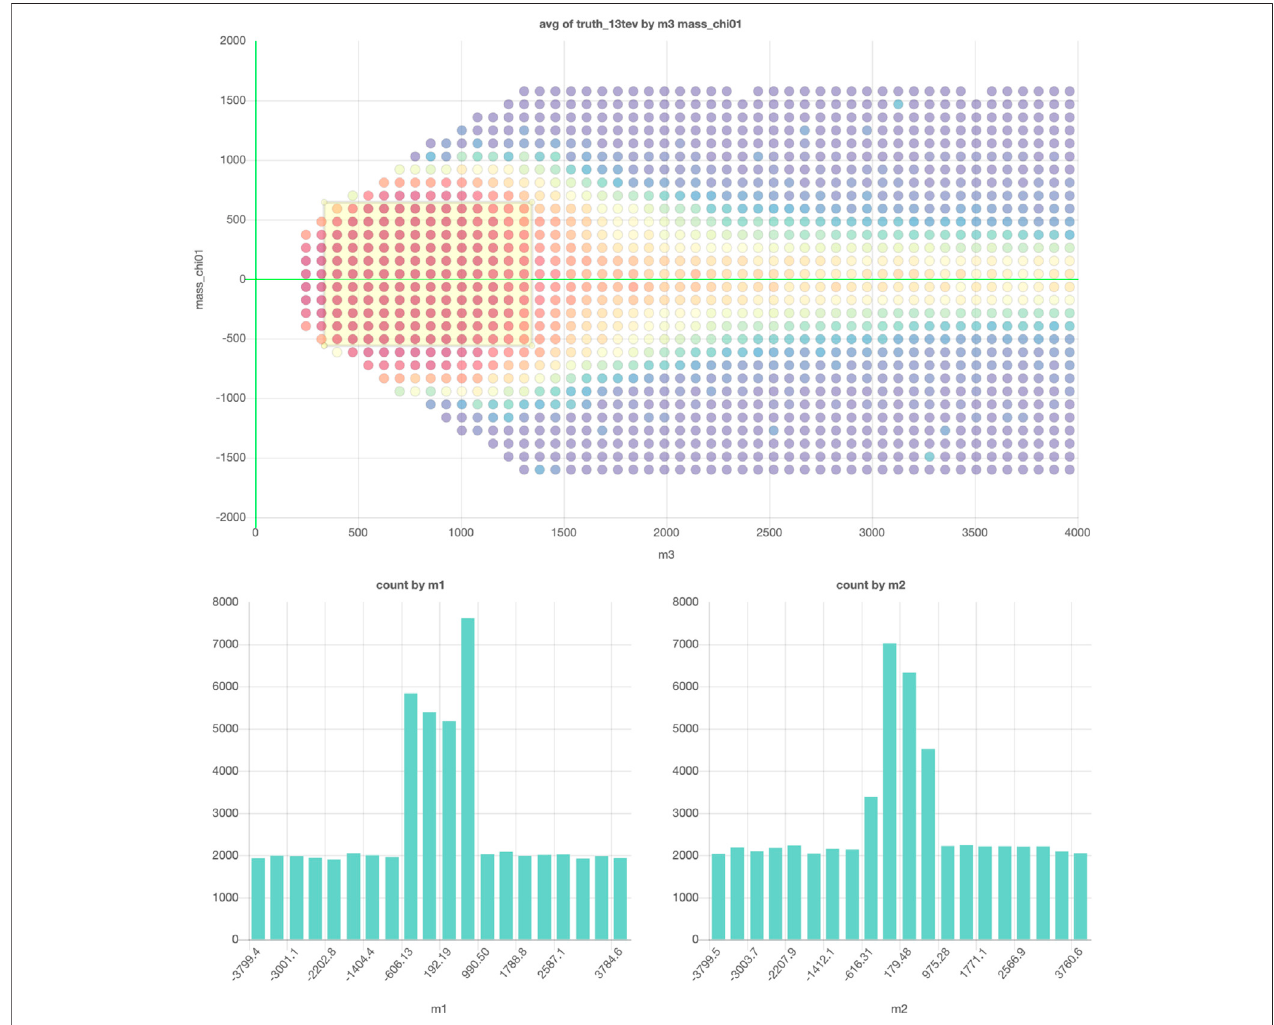
FIGURE 4 | The example projection made of a subset of the data in ATLAS collaboration (2015). The graph on top shows the projection on two of the 19 free parameters and the colors indicate the average exclusion for the model con fi gurations in each for the bins. The two graphs on the bottom can be used to make cuts on two of the remaining 17 parameters. Interactive dashboard of these graphs can be accessed here.